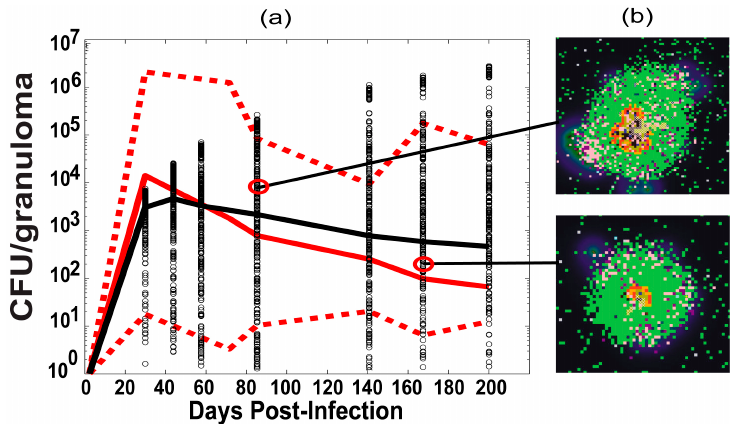
Figure 3. Computational model calibration: LUNG. ( a ) Time courses of CFU per granuloma. In red are shown NHP experimental data (median, max and min) for colony-forming-units (CFU)/granuloma (see details in the Supplementary File 2. They are plotted here versus our in silico datasets (black) of CFU/granuloma (lung compartment) from our computer simulations of 3000 granulomas coupled to the blood and LN dynamics). The x -axis shows a time span of infection up to 200 days to match the NHP blood data. The y -axis represents bacteria levels as CFU/granuloma. The in silico dataset of time courses of CFU/granuloma generated in the lung compartment (black circles, with the black solid line representing the median trajectory) are plotted together with experimental data on NHP CFU/granuloma (with the solid red line representing the median, and the dotted red lines representing the min and max values in the NHP data). The median trajectories for both the NHP and in silico data are calculated including the granulomas that cleared infection (Mtb < 1), while the min trajectories excluded them. ( b ) Two snapshots of in silico granuloma corresponding to the points in the time courses of panel (a)